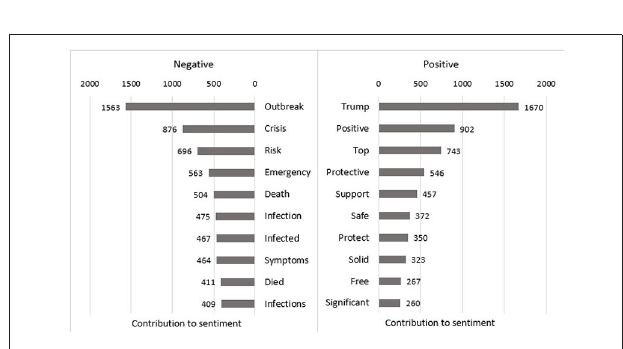
FIGURE 6 | GN frequency contribution to sentiment